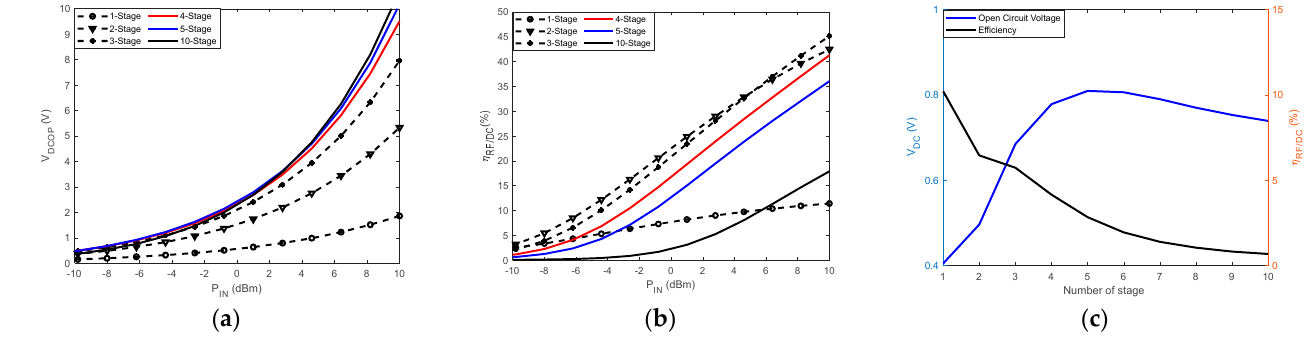
Figure 13. Performance comparison of multistage rectifiers. ( a ) Voltage. ( b ) Efficiency. ( c ) The trade-off between voltage and efficiency.